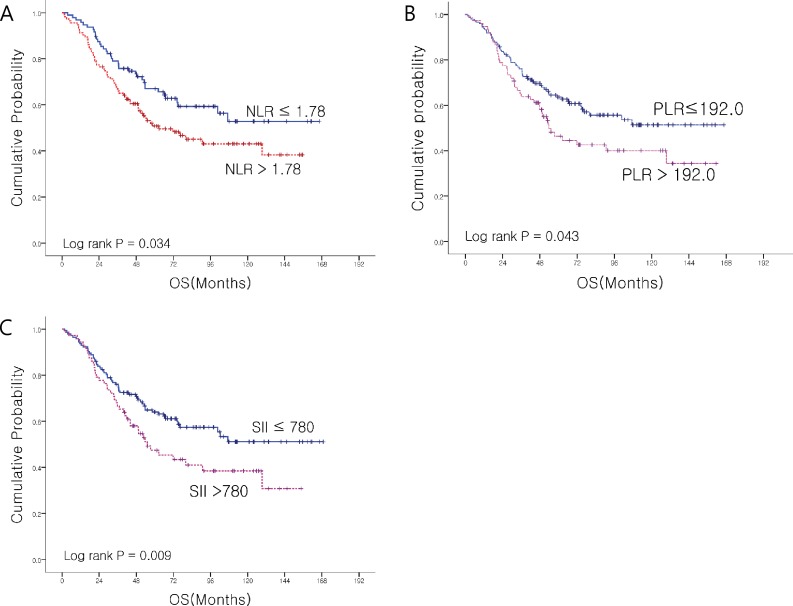
OS according to NLR (A), PLR (B) & SII(C). (A)(B) show OS according to NLR and PLR. High NLR and high PNR has poorer OS than low NLR, low PLR. (C) shows OS according to SII, high SII also poorer OS, also.